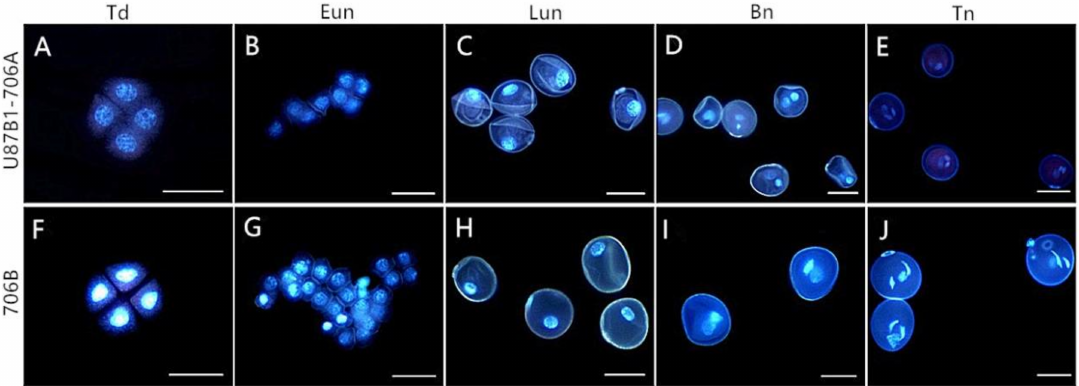
Figure 5. DAPI staining of microspores in U87B1-706A ( A – E ) and 706B ( F – J ). ( A , F ) Td, tetrad stage; ( B , G ) Eun, early uninucleate stage; ( C , H ) Lun, late uninucleate stage; ( D , I ) Bn, binucleate stage; and ( E , J ) Tn, trinucleate stage. Scale bars are 50 µ m in ( A – J